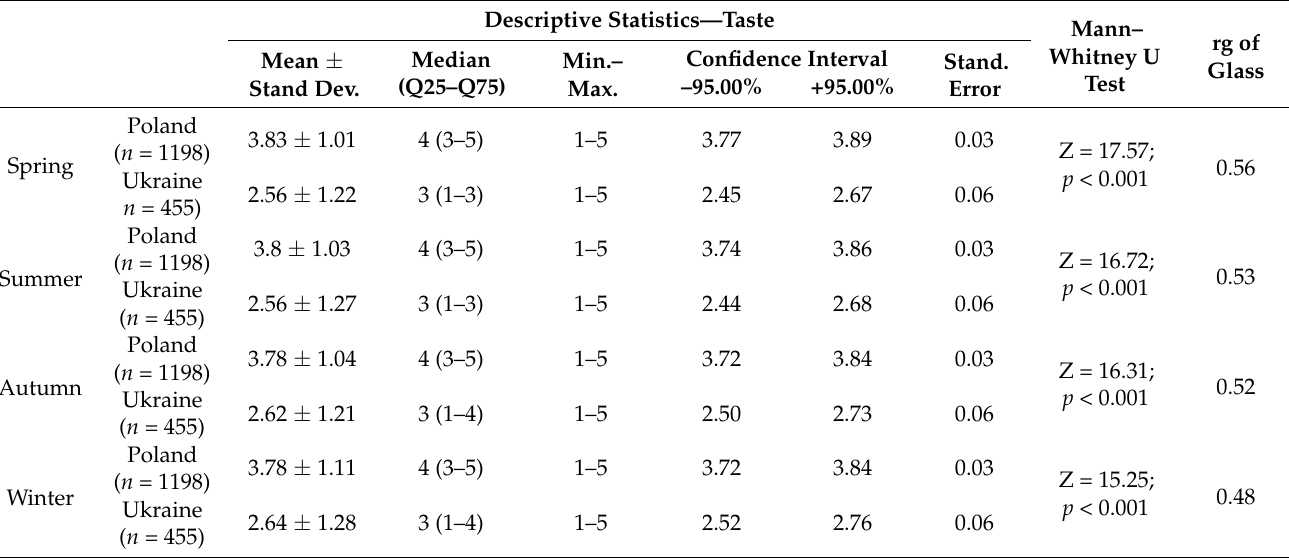
Table 8. Comparison of the groups of respondents from Poland and Ukraine in terms of evaluation of the taste of tap water during individual periods of the year.